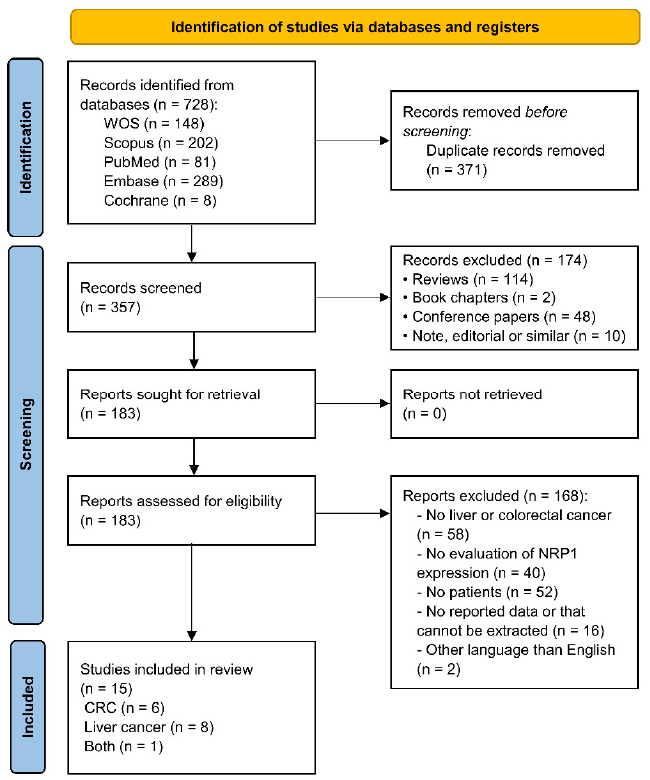
Figure 1. PRISMA flow diagram of study selection. CRC, colorectal carcinoma; Embase, Excerpta Medica Database; NRP1, neuropilin-1; WOS, Web of Science.